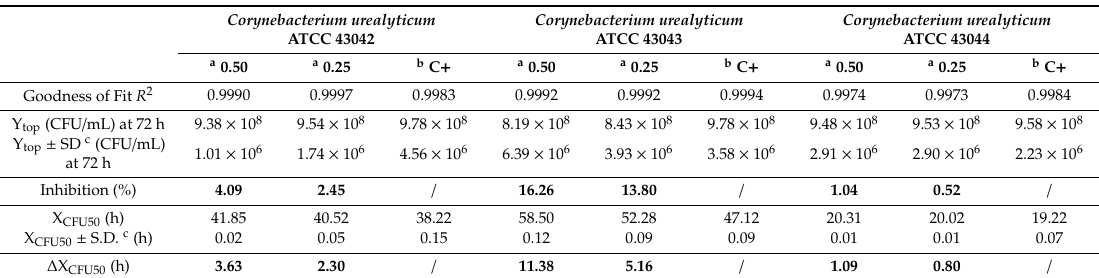
Table 1. In vitro bacterial grown curve